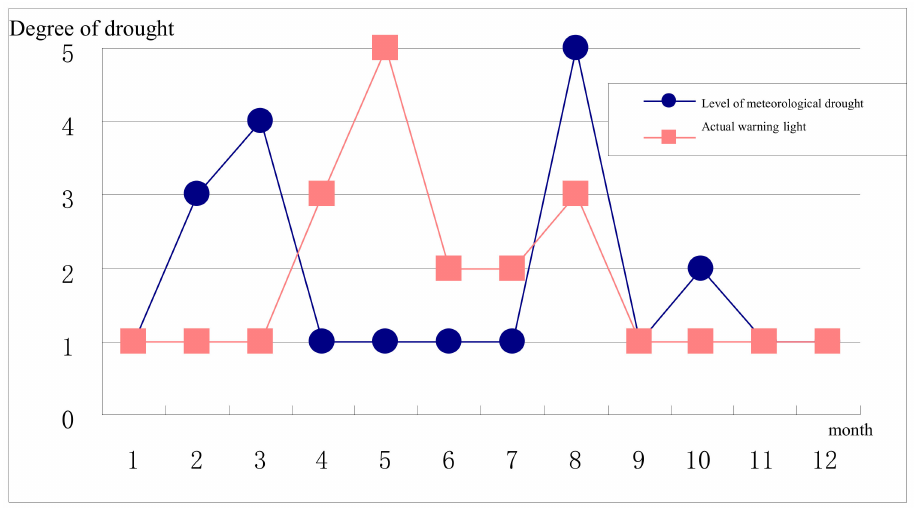
Figure 4. Monthly precipitation-related drought degrees and actual early warning signals in